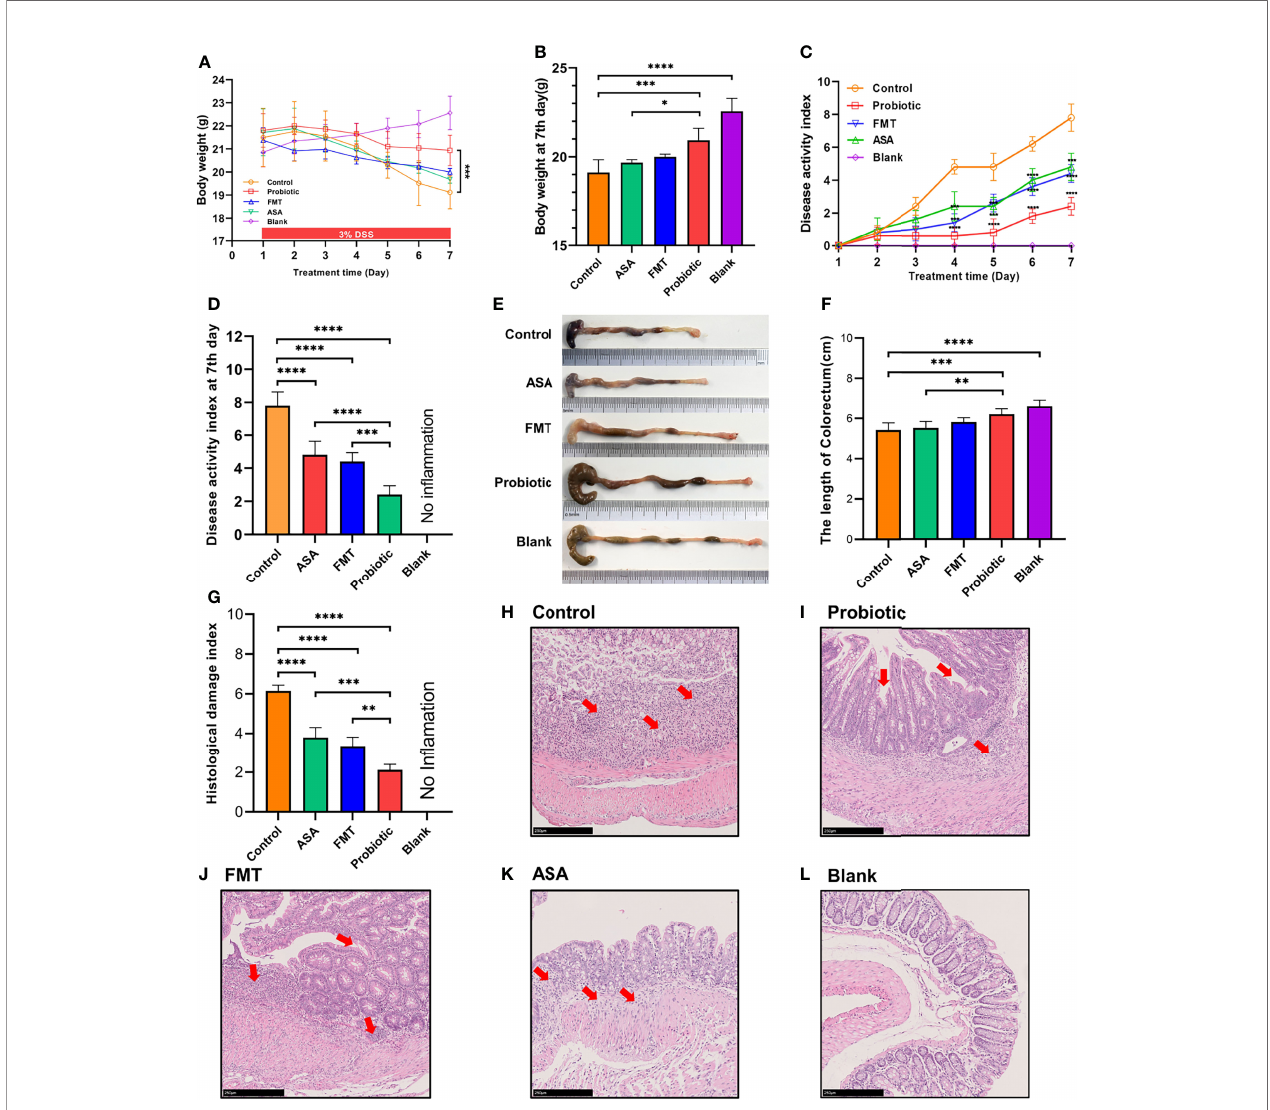
FIGURE 1 | The probiotic cocktail alleviates intestinal in fl ammation in the DSS-induced colitis model. (A) Body weight of blank mice, and DSS-induced colitis mice treated with PBS, healthy mice donor FMT, 5-ASA, or the probiotic cocktail for 7 days. (B) The average body weight of each group at day 7. (C) The DAI score in each group. (D) The average DAI score at day 7. (E) Representative images of the colon in each group at day 7. (F) Colon length shown as a chart. (G) The HDI scores in each group based on in fl ammatory cell in fi ltration and mucosal damage under microscopic observation. (H – L) Representative image of colon tissue stained with H&E from each group. One-way ANOVA test was utilized, and data were shown as mean ± SD. * p < 0.05; ** p < 0.01; *** p < 0.001; **** p < 0.0001. DSS, dextran sodium sulfate; PBS, phosphate buffered saline; FMT, fecal microbiota transplantation; 5-ASA, 5-aminosalicylic acid; DAI, disease activity index; HDI, histological damage